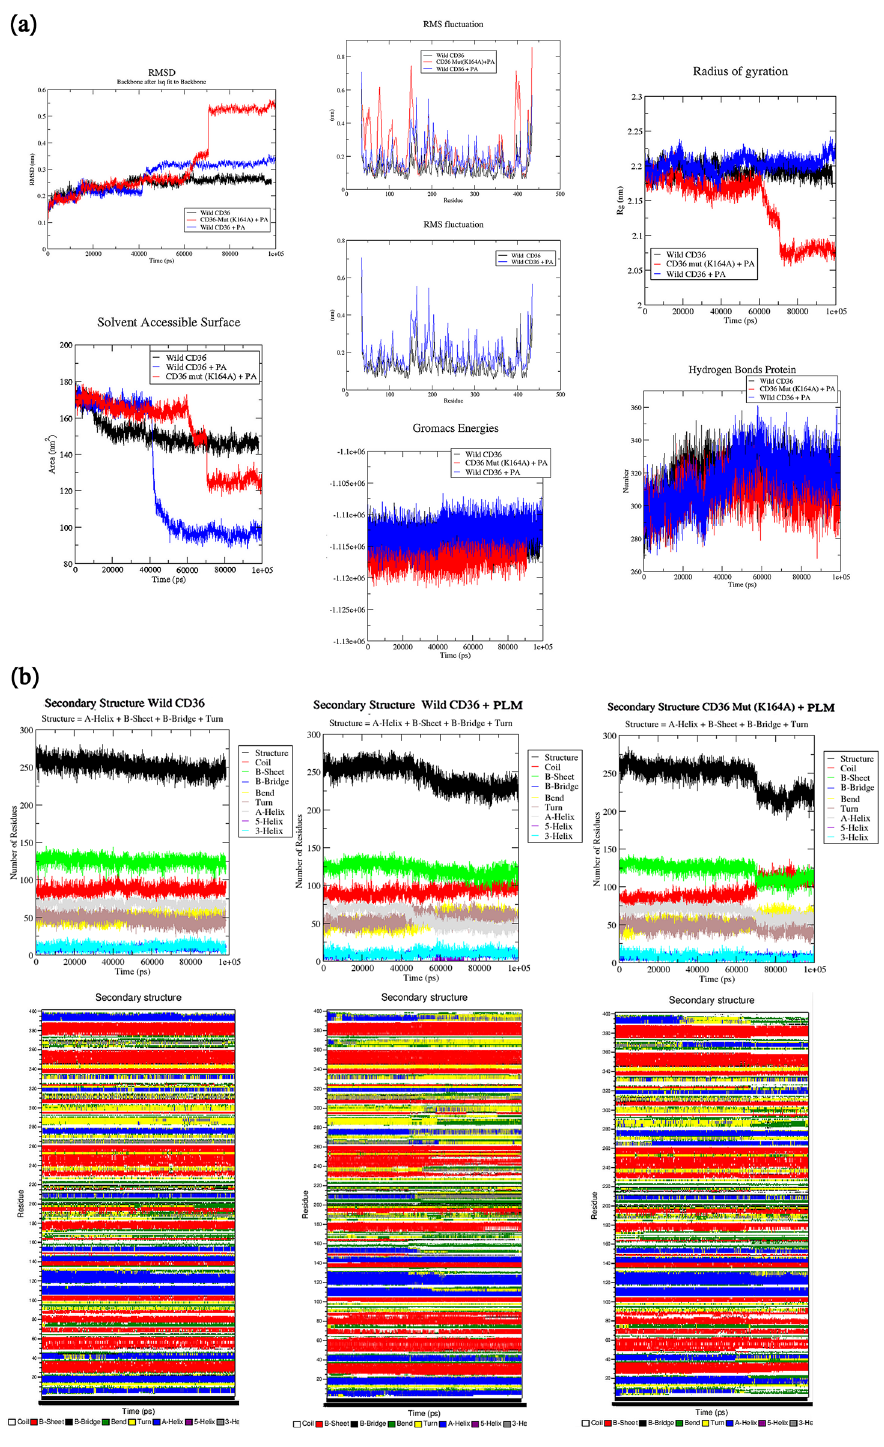
Figure 2. ( a ) Dynamics analyses of plamitic acid (PLM) uptake across the wild and mutant type CD36 receptor. RMSD plot, Backbone residual fluctuations (RMSF) plot, time evolution of Radius of Gyration (Rg), Solvent Accessible Surface (SASA), Gromacs Energies and Hydrogen Bonds for wild and mutant type of CD36 in presence and absence of PLM a function of time during 100,000 ps (100 ns). Black, blue, and red, represent values obtained for Wild type CD36 in absence of PLM, wild type CD36 in presence of a single PLM, mutant K164A type CD36 in e of in presence of a single PLM respectively. ( b ) DSSP analysis for the secondary structure fluctuations as a function of time from 0 to 100 ns of plamitic acid (PLM) uptake across the wild and mutant type CD36